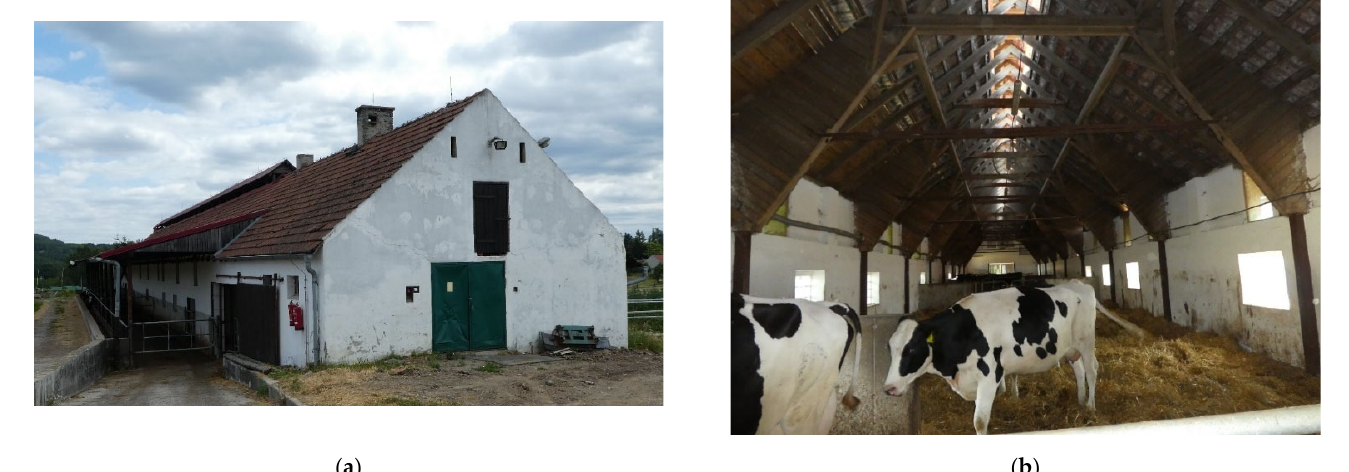
Figure 6. The cowshed for dry cows (DC): ( a ) exterior view; ( b ) the interior of the cowshed for dry cows.